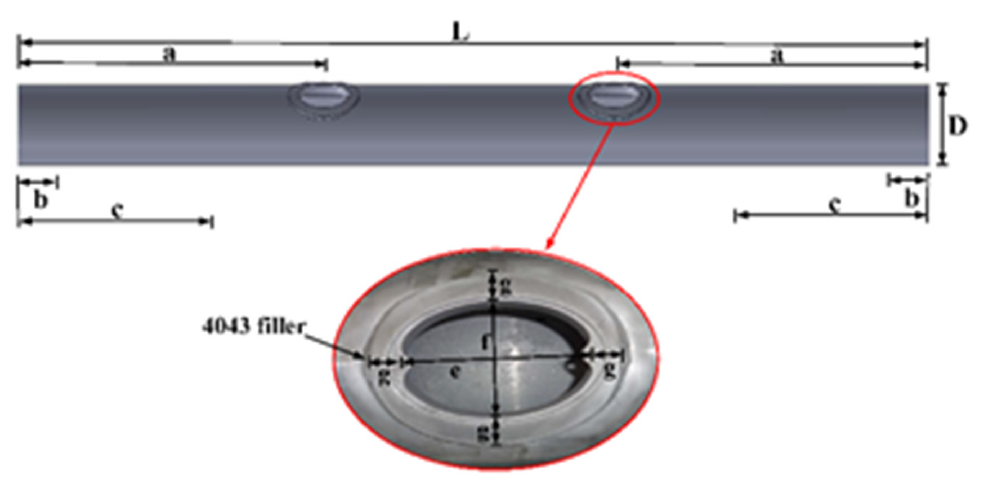
Figure 2. Typical geometry of a welded aluminum hand-hole detail in four-point fatigue testing. (In this study there was no welded detail). (L = 3.66 m (144 in); D = 25.4 cm (10 in); a = 1.37 m (54 in); b = 15.2 cm (6 in); e = 150 mm (6 in); f = 100 mm (4 in)). Table 1 is a summary of the minimum mechanical properties of the aluminum tube. Table 1. Mechanical properties of the aluminum tube.